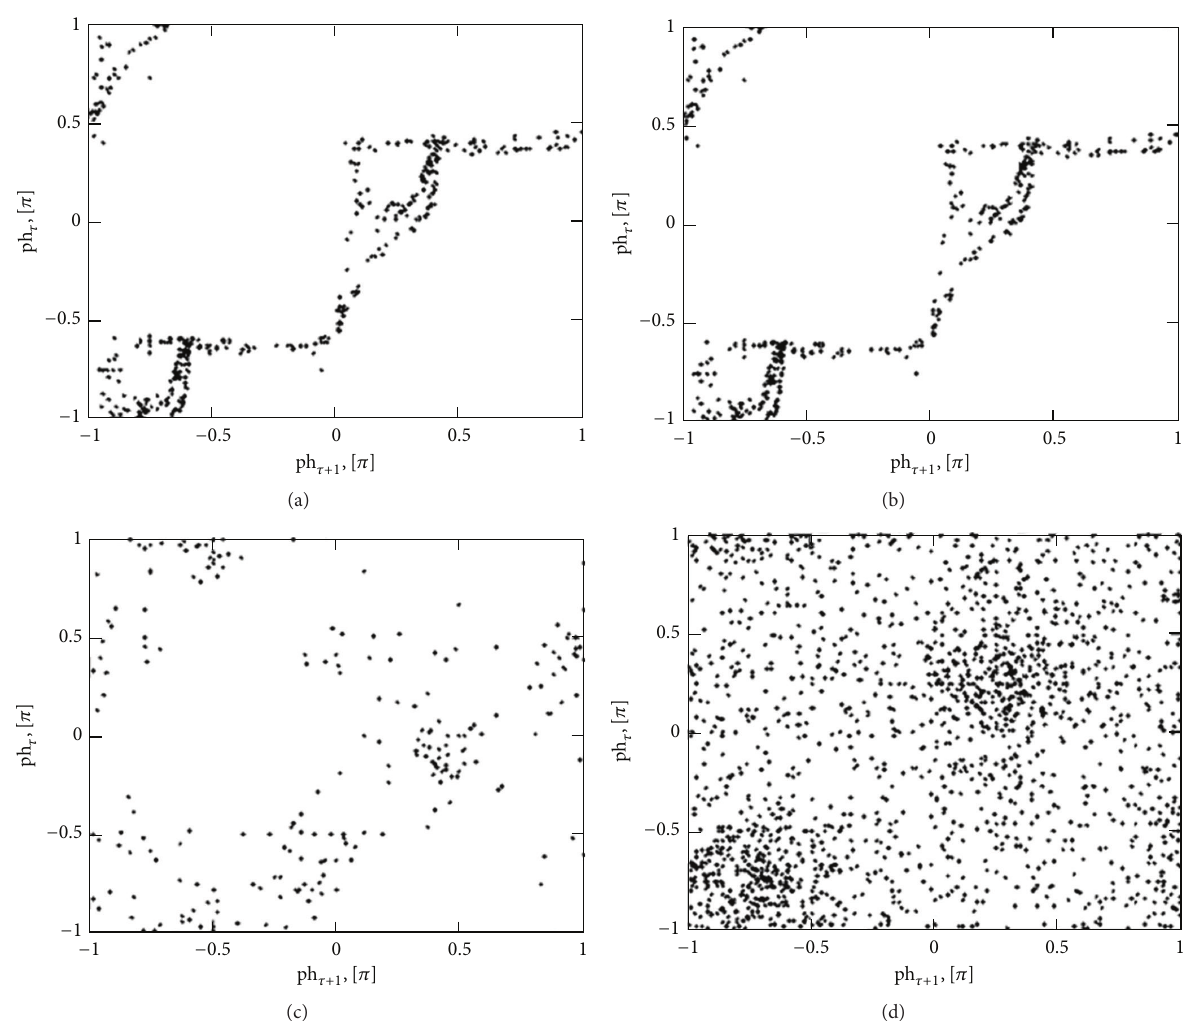
Figure 8: Angular first-return map from the noise 𝑋 -Lorenz coordinate corresponding to (a) SNR = 1000; (b) SNR = 100; (c) SNR = 10; (d) SNR =